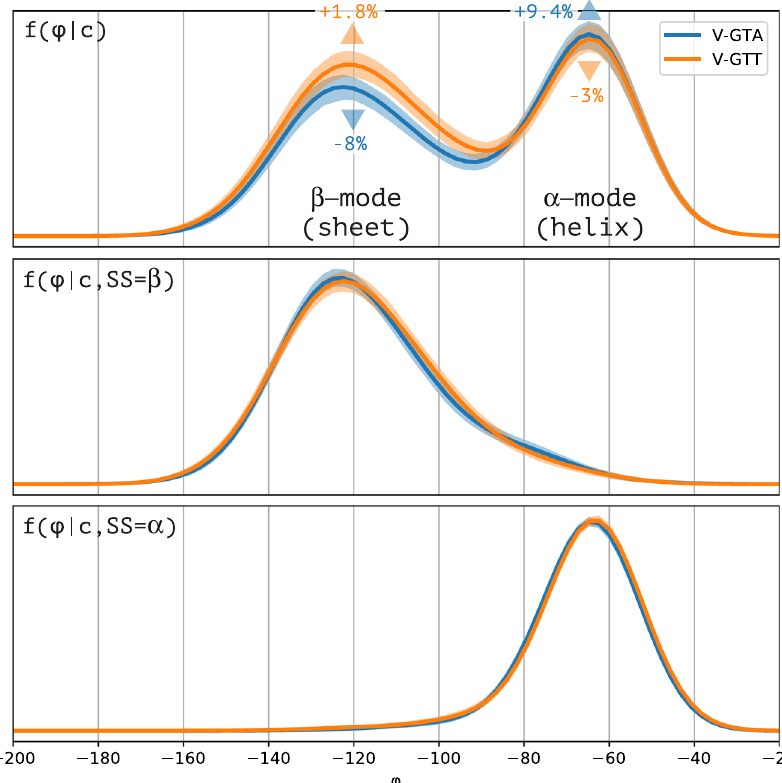
Fig. 2 Different propensities for secondary structures of synonymous codons are manifested in the dihedral angle distribution. Out of the two codons GTA and GTT translating valine, GTA has 8% lower propensity for the β mode and 9.4% higher propensity for the α mode. Propensities are manifested through the relative weights of the corresponding modes in the Ramachandran plot, which is visible in the marginal distributions of the dihedral angle φ plotted here. When conditioned by secondary structure (i.e., restricted to a speci fi c mode), the distributions of the two synonymous codons become indistinguishable. By conditioning on secondary structure, our analysis is made robust to distribution differences arising from propensities differences. Kernel density estimates are shown with the shaded regions denoting 10 – 90% con fi dence intervals calculated on 1000 random